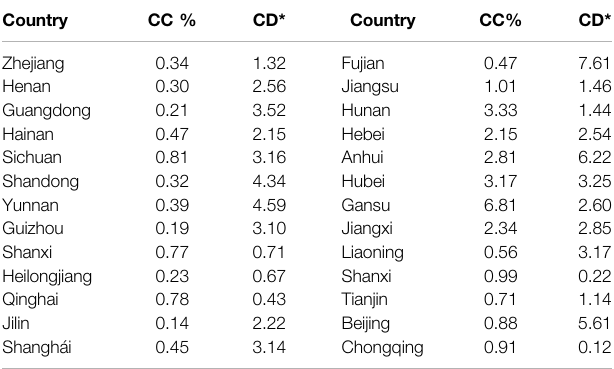
TABLE 1 | Individual Indicator Index. Country